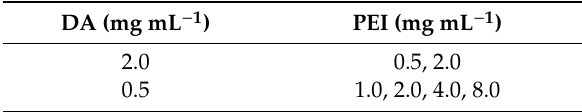
Dopamine (DA) and polyethyleneimine (PEI) concentrations used for UH050 membrane